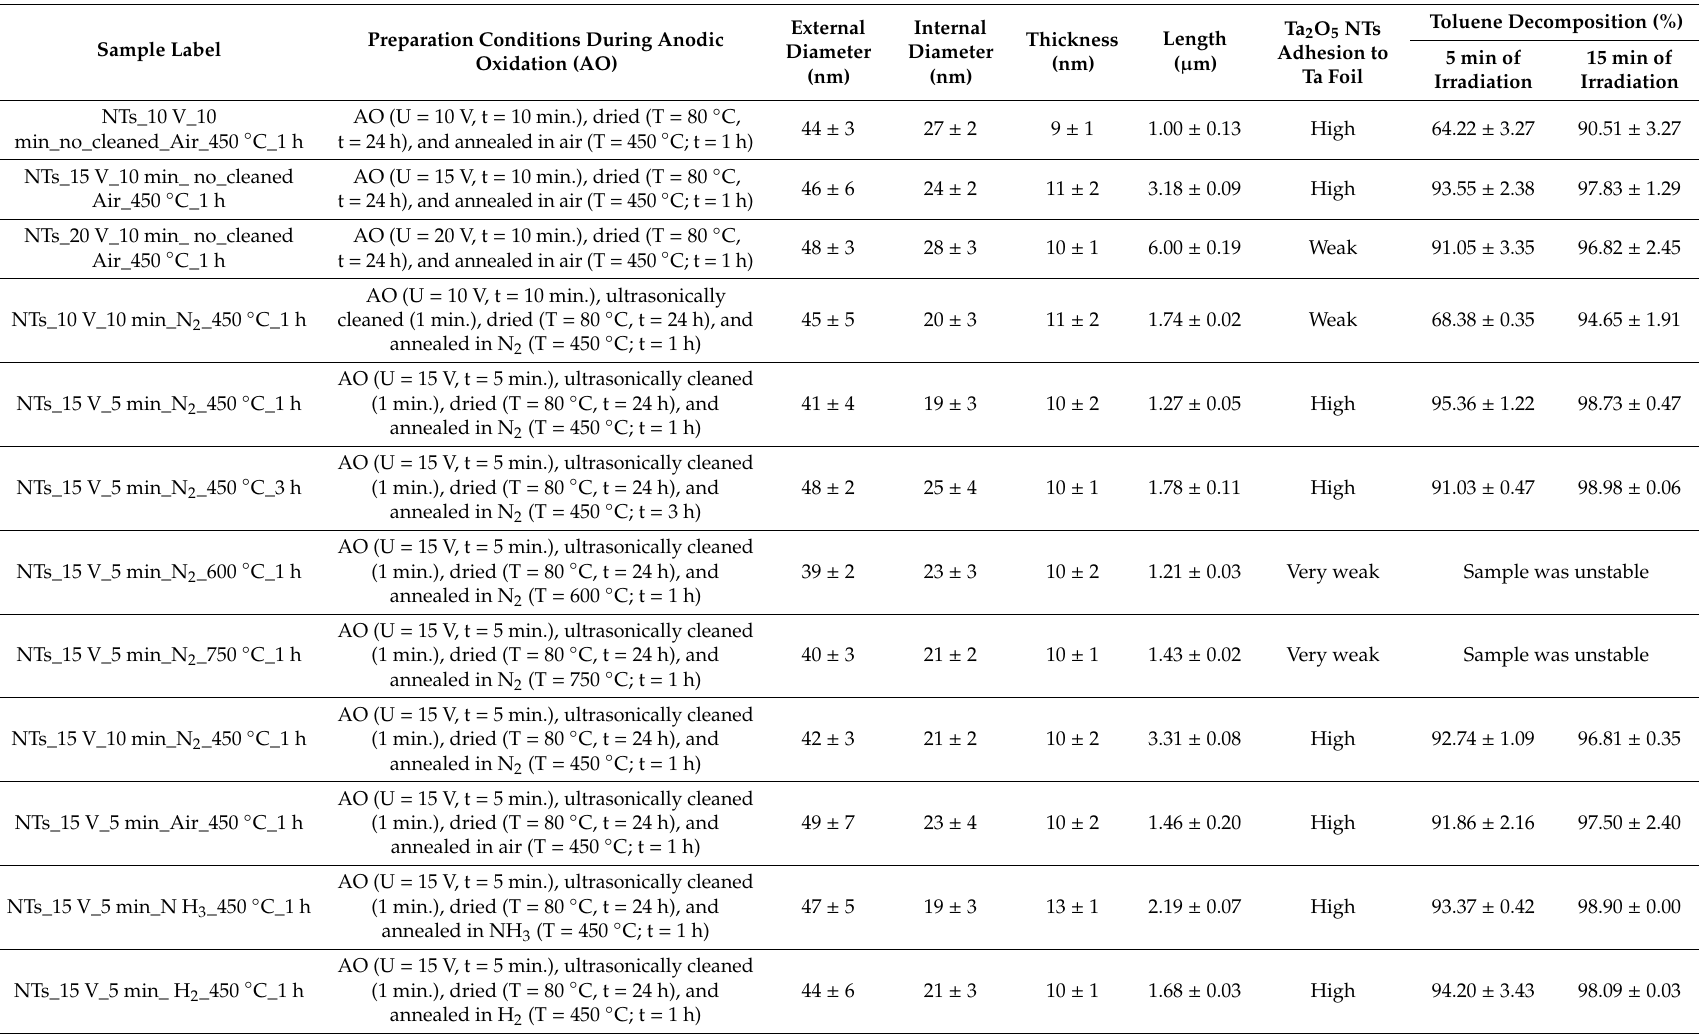
Table 1. Sample labels, synthesis conditions, morphology, and photoactivity of bare and quantum dot (QD)-decorated nanotube arrays